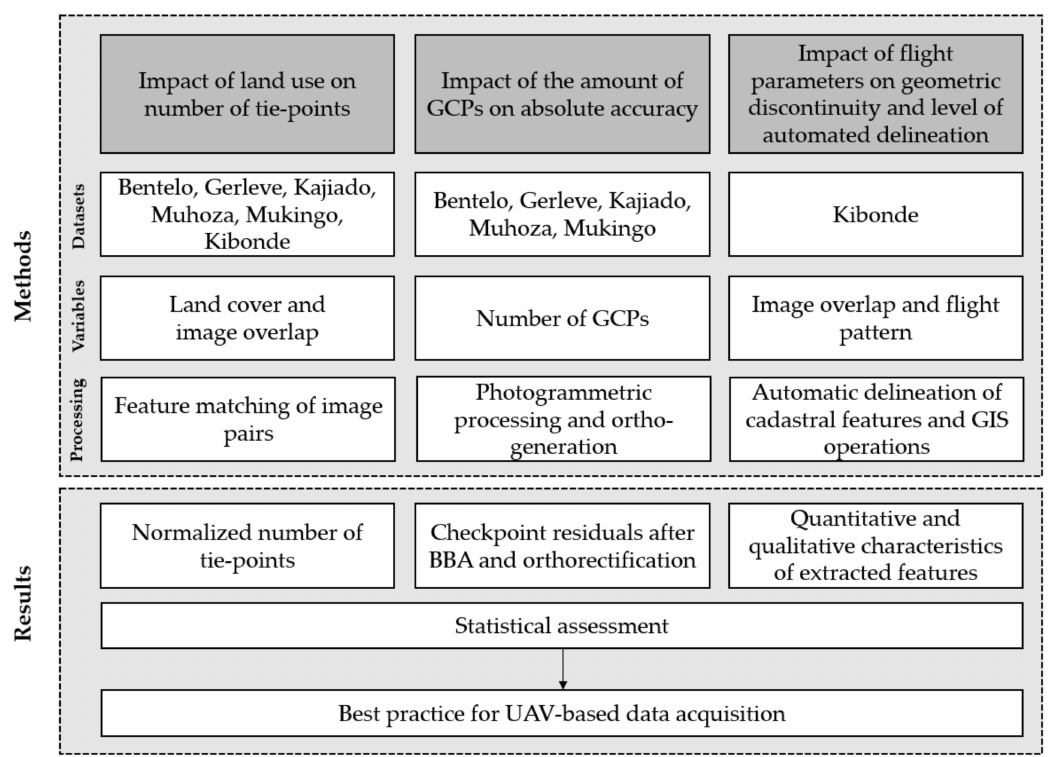
Figure 1. Conceptual